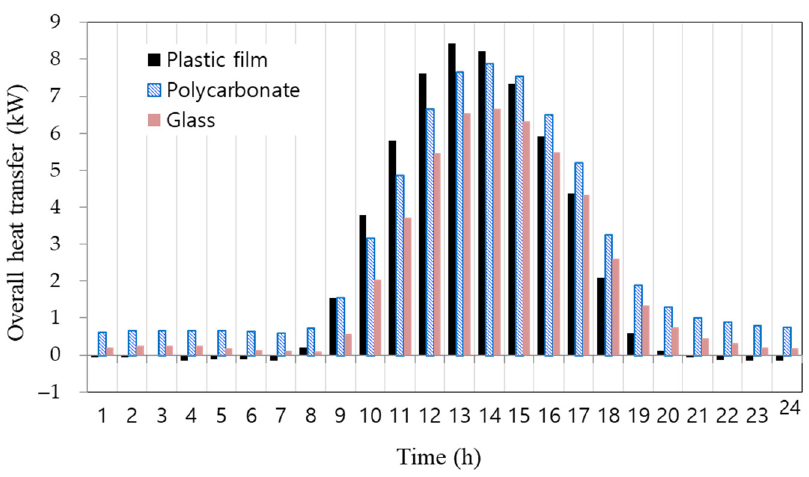
Figure 14. Hourly variations in heat flux in greenhouses covered with different covering materials (12 − 13, 19 − 20, and 26 − 27 October